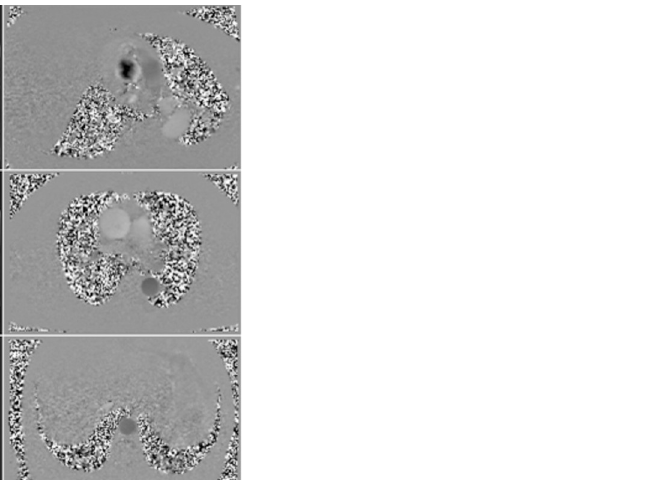
Fig 3. Phase-contrast